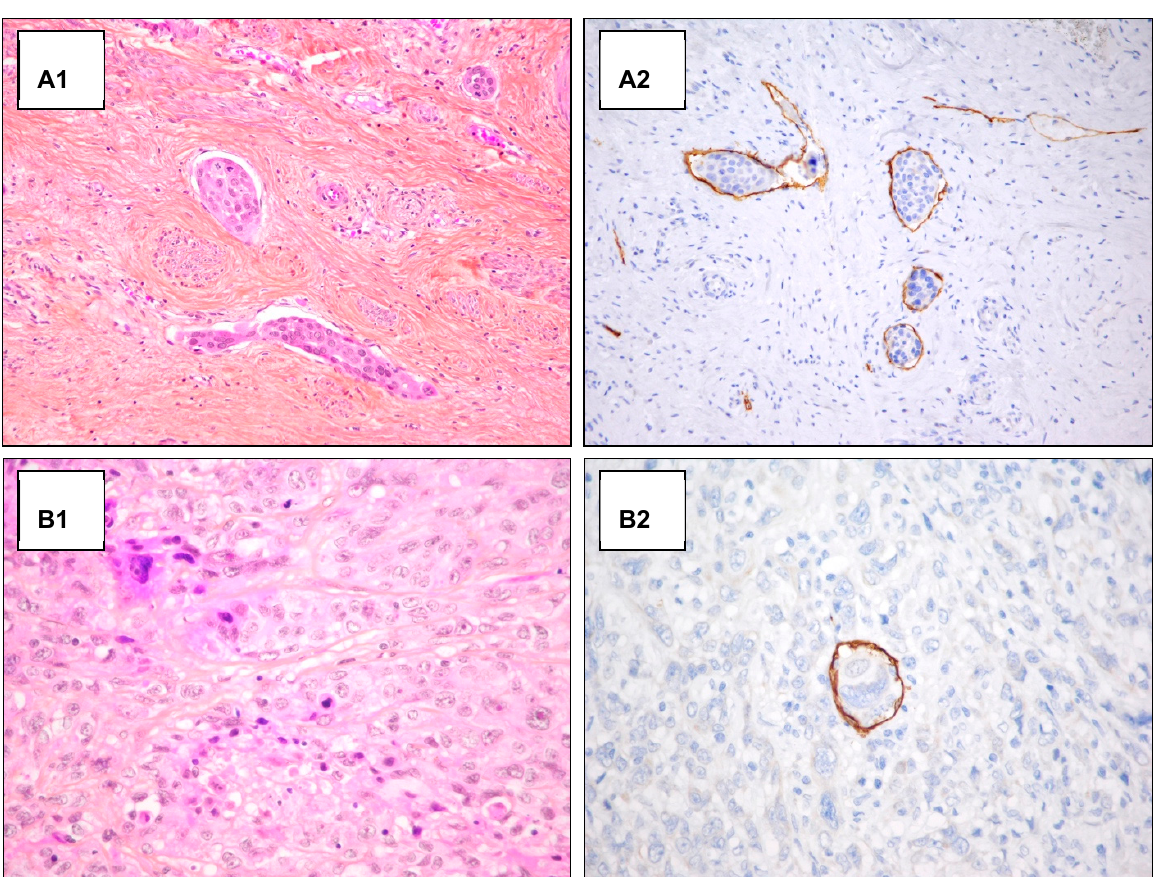
Figure A1. H/E staining and D2-40 antibody staining in emboli detection. Examples of detection of lymphatic invasion in H&E staining and D2-40 antibody staining. ( A ) Detection of peripheric emboli in H&E staining ( A1 ) and D2-40 antibody staining ( A2 ) (original magnification 200×). ( B ) Unclear detection of intra-tumoral emboli in H&E staining ( B1 ), after D2-40 antibody staining the intra-tu- moral emboli detection appear clear (original magnification 400×) (B2).